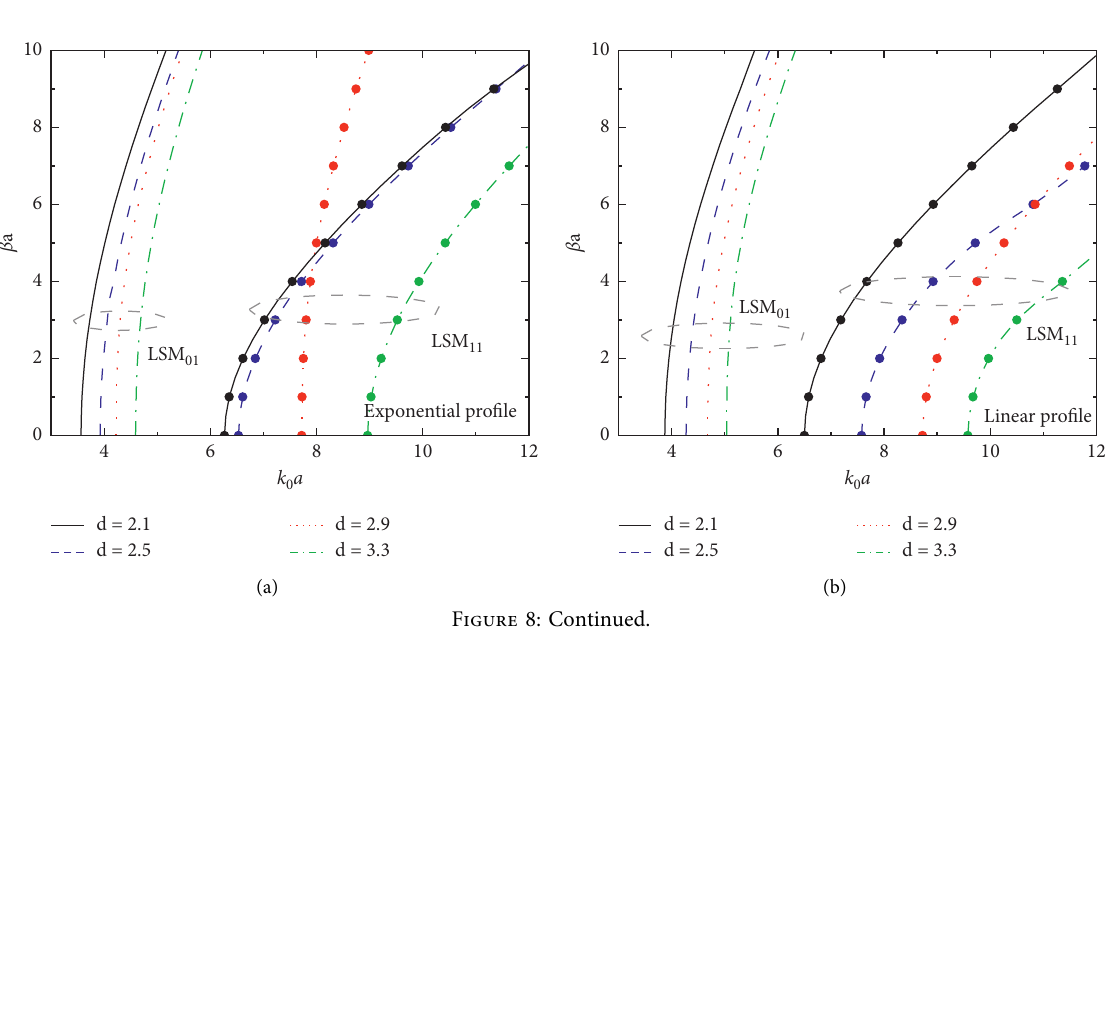
Figure 7: The dispersion relations of LSM modes for constant, linear, parabolic, and exponential profiles and the dispersion of the TM modes of a hollow rectangular waveguide with the same